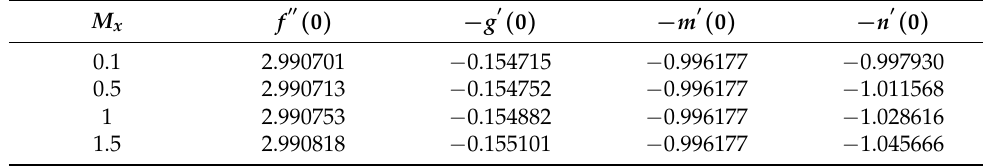
Table 6. Estimated values for f (cid:48)(cid:48) ( 0 ) , − g (cid:48) ( 0 ) , − m (cid:48) ( 0 ) , and − n (cid:48) ( 0 ) with fixed S z = − 0.1, M y = 0.3, R m = 0.01, S = 1, and different values of M x .